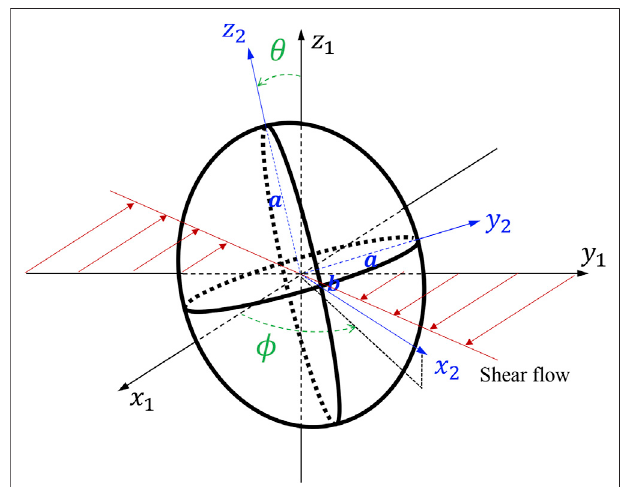
FIGURE 1 | A tumbling oblate with ( x 1 , y 1 , z 1 ) and ( x 2 , y 2 , z 2 ) frames of